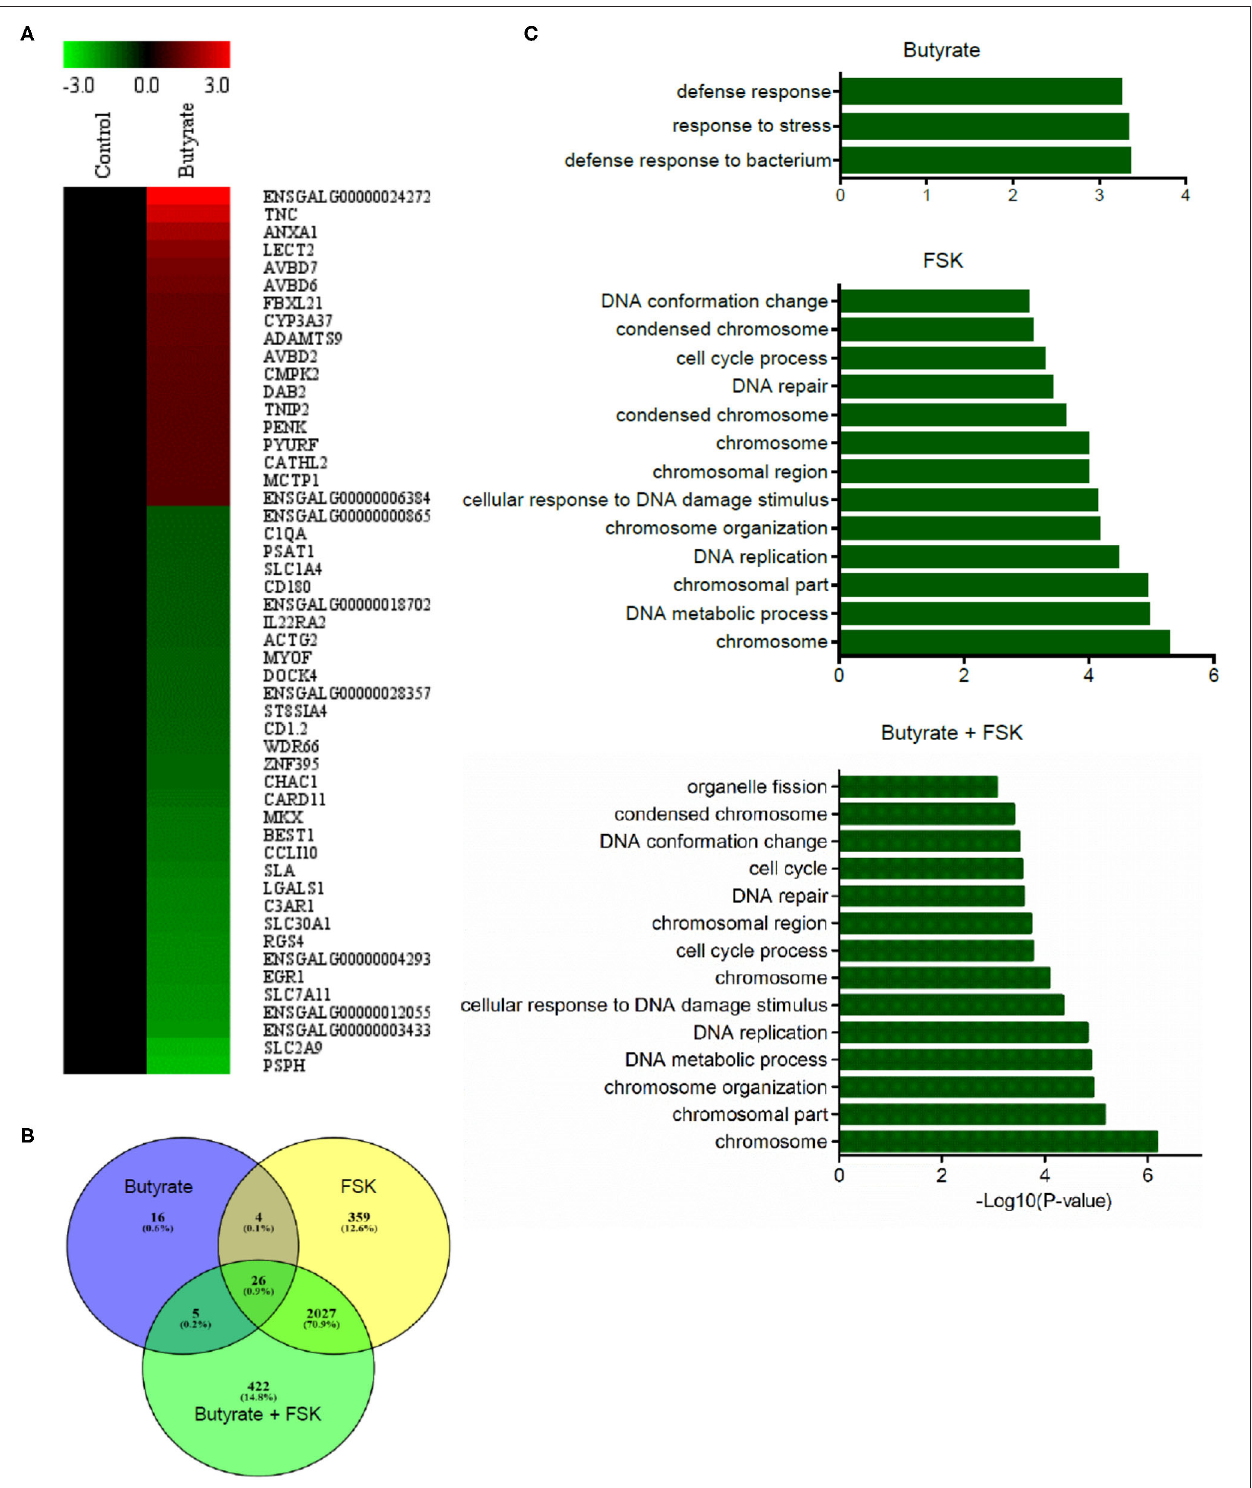
FIGURE 5 | Transcriptome profiling of chicken macrophages in response to butyrate and FSK. Chicken HD11 cells were treated in duplicate with or without 2mM butyrate, 5 µ M FSK, or in combination for 24h, followed by RNA isolation and sequencing. (A) Differential expression of genes in response to butyrate. Fold changes in the heatmap were log 2 transformed. Red color denotes upregulation, while green color denotes downregulation. (B) Venn diagram showing the number of differentially expressed genes overlapping among the three treatments. Differentially expressed genes were selected with > 2-fold difference (relative to the control) and FDR < 0.05. (C) Differential enrichment of cellular processes to butyrate and FSK. Only the GO terms and KEGG pathways with P < 0.05 were considered significantly enriched.